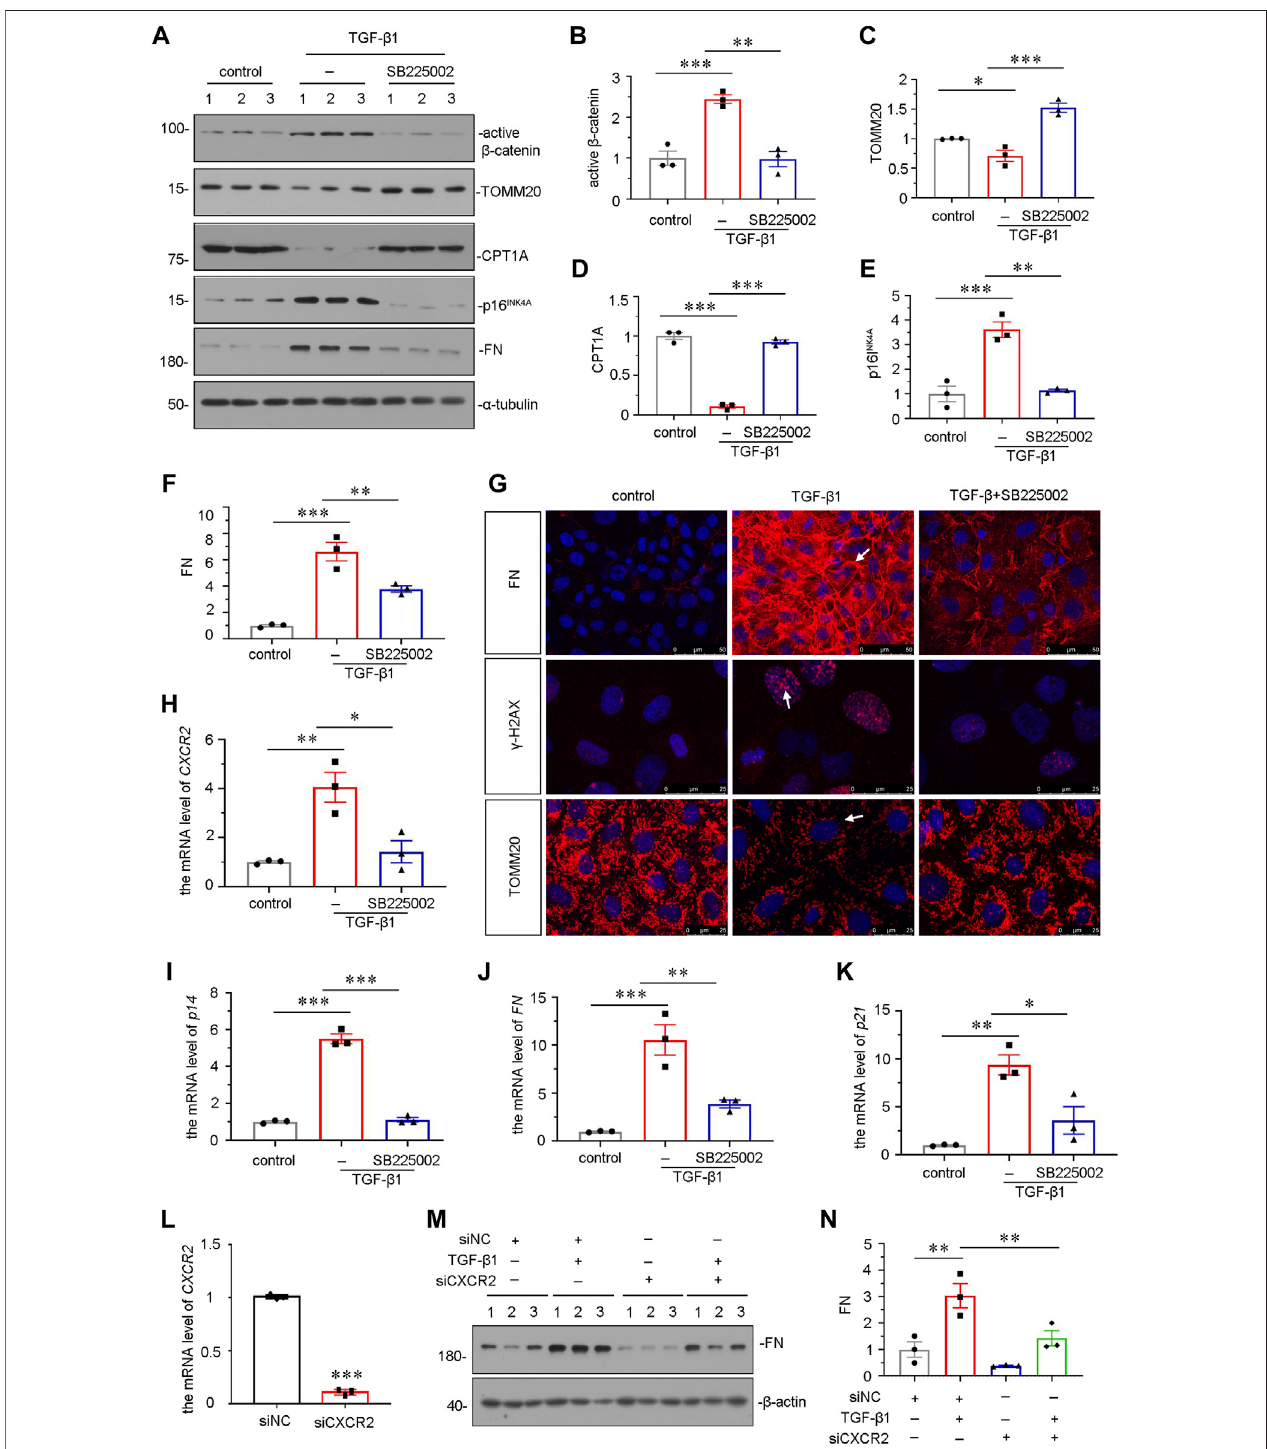
FIGURE 6 | SB225002 retards cellular senescence and mitochondrial dysfunction in TGF- β 1-treated tubular cells in vitro . (A – F) Representative micrographs of westernblotandquantitativestatisticaldatashowingproteinexpressionallevelsof (B) active β -catenin, (C) TOMM20, (D) CPT1A, (E) p16 INK4A and (F) FNineachgroup. * p < 0.05, ** p < 0.01, *** p < 0.001, n = 3. (G) Representative micrographs show the protein expressional level of FN, γ -H2AX and TOMM20 in each group, as indicated. Frozen sections were stained with FN, γ -H2AX and TOMM20 antibodies, respectively. Arrows indicate positive staining. Scale bar = 50 or 25 μ m. (H – K) Graphical representations show the relative mRNA level of (H) CXCR2 , (I) p14, (J) FN and (K) p21 in each group. * p < 0.05, ** p < 0.01, *** p < 0.001, n = 3. (L – N) Graphical representationsshowtherelativemRNAlevelof CXCR2 aftersiRNAtransfection (L) .*** p < 0.001, n =3.Representative (M) Westernblotsandgraphicalrepresentations of (N) FN expression in four groups. HKC-8 cells were transfected with siCXCR2 or siNC and then treated with TGF- β 1 (2 ng/ml) for 24 h.